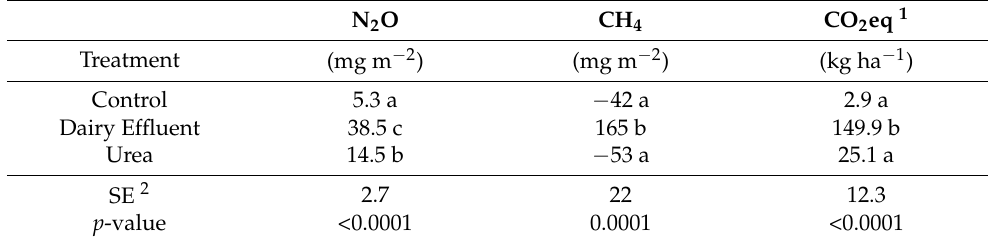
Table 4. Estimated cumulative N 2 O and CH 4 fluxes during the 62-day measuring